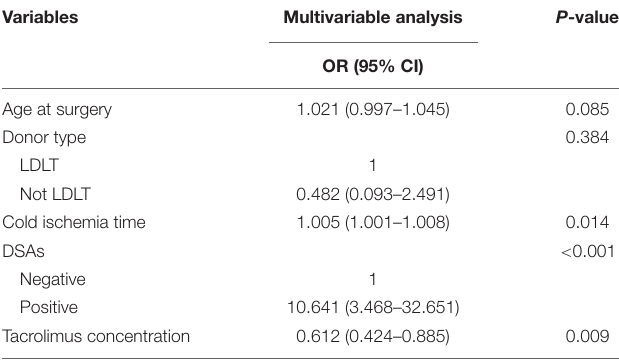
TABLE 2 | Results of multivariable logistic regression analyses.